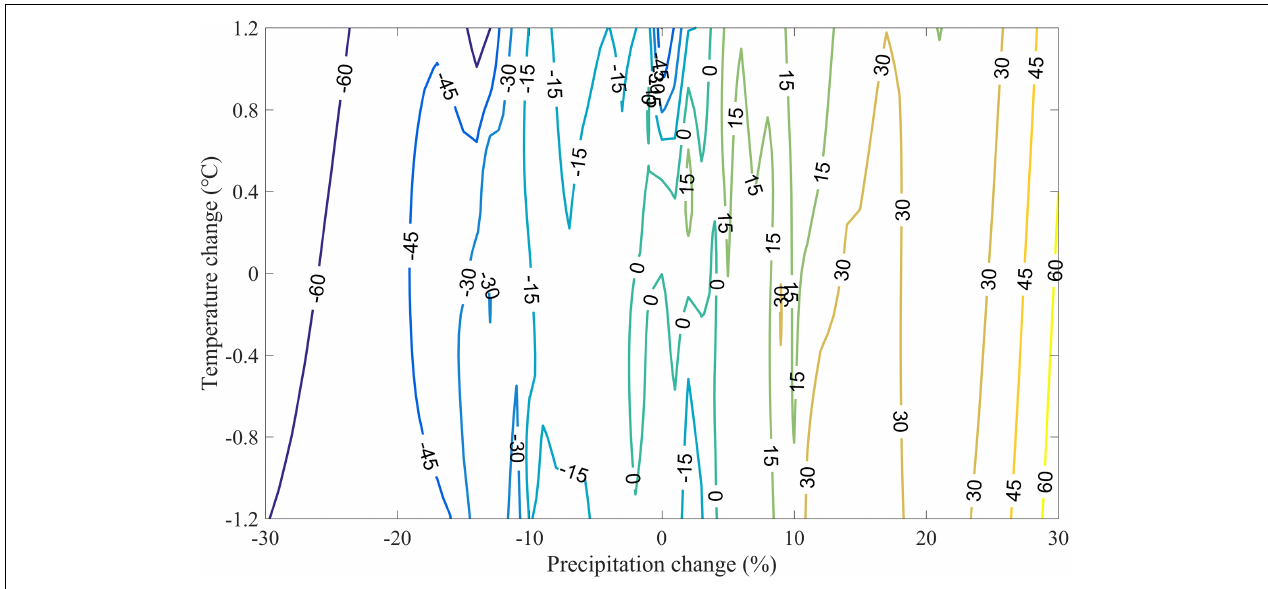
FIGURE 6 | Contour plot of annual streamflow change (%) as a function of annual precipitation and temperature changes for the Xi River basin in the future.